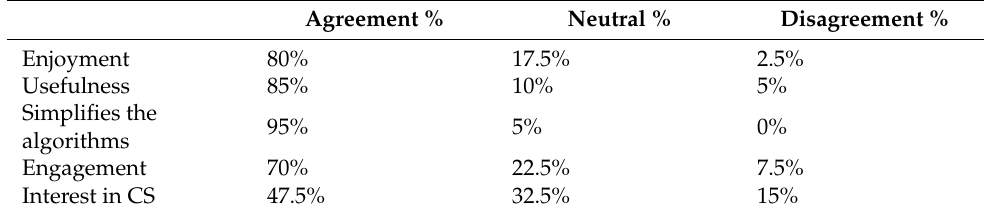
Table 1. Students’ responses to the survey questionnaire for the Data Structures course.